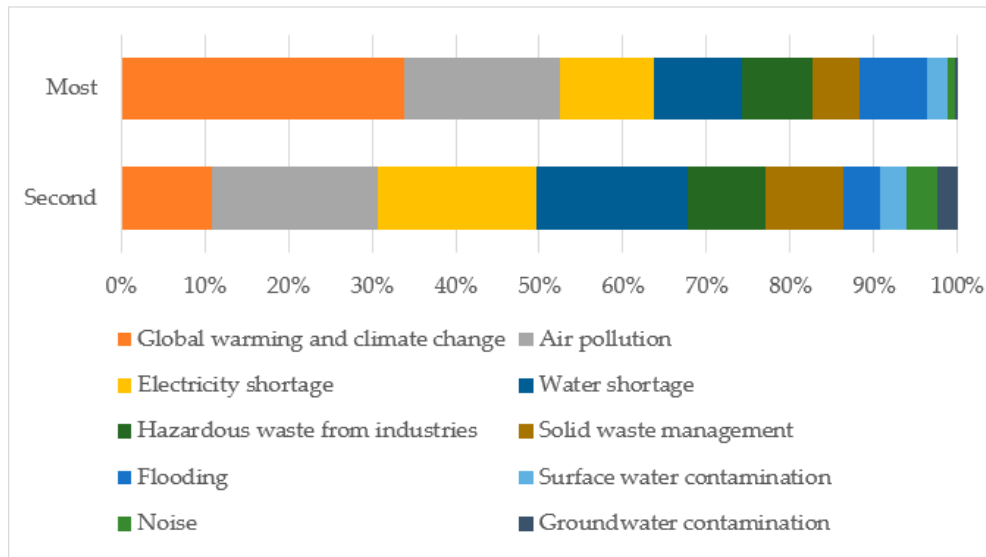
Figure 5. Energy/environmental problems considered to be of most or second most importance.